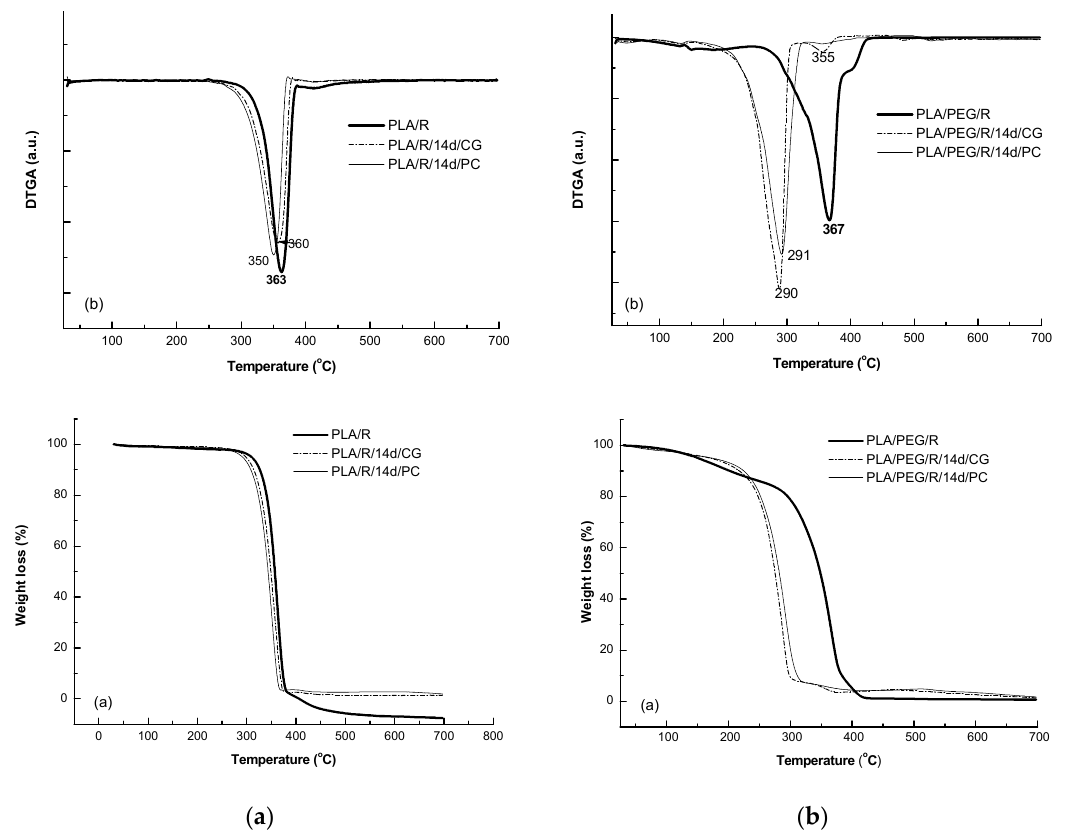
Figure 11. TG/DTG curves of PLA/R ( a ) and PLA/PEG/R samples before and after biodegradation ( a ) Figure 11. TG / DTG curves of PLA / R ( a ) and PLA / PEG / R samples before and after biodegradation TG curves and ( b ) first derivative DTG curves. ( a ) TG curves and ( b ) first derivative DTG